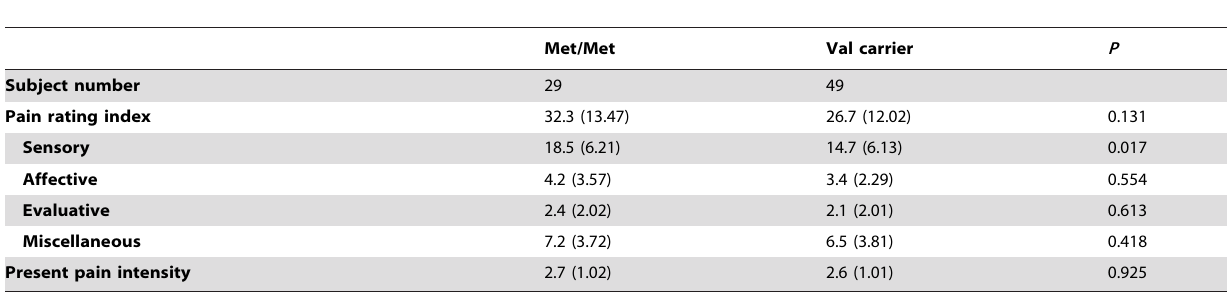
Table 3. BDNF rs6265 genotype effect on McGill Pain Questionnaire scores of PDMs during the menstrual